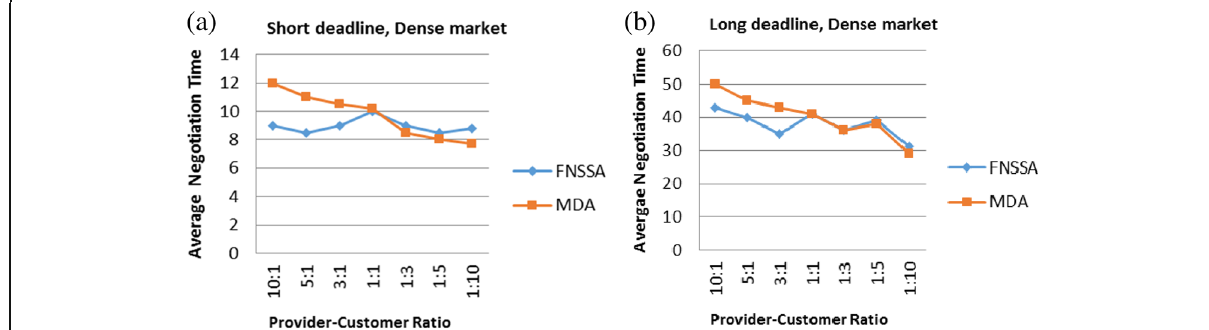
Fig. 10 Fig. 10 Average negotiation time of the CRPAs under a short deadline and dense market, and b long deadline and dense market. In